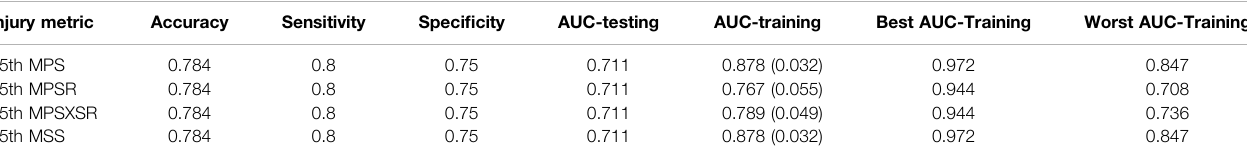
TABLE 4 | Summary of the performance scores of the four different injury predictors. The scores were obtained using the leave-one-out cross-validation framework. The AUC-training values are presented as the average (standard deviation) of the testing datasets. The best and worst AUC-training measures are also reported. Injury